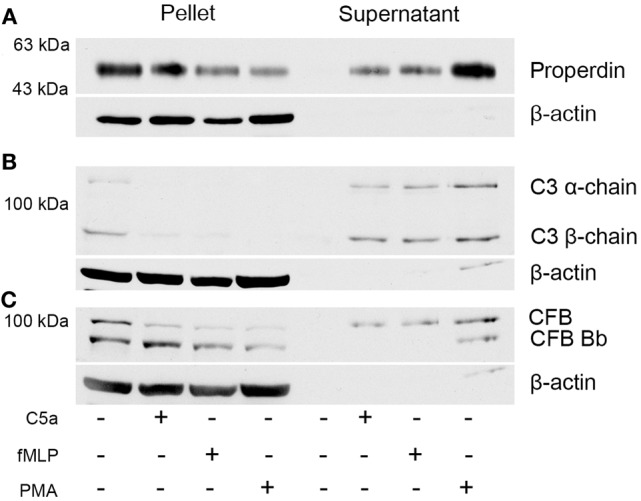
Neutrophils secrete complement proteins upon activation with PMA, fMLP, and C5a. Neutrophils were activated with C5a (1 μM), fMLP (1 μM), and PMA (20 nM) for 30 min. Cells were harvested by centrifugation, and the supernatant was collected to investigate for secreted proteins. Western blot analysis of the pellet and the supernatant reveals that neutrophils contain (A) CFP, (B) C3, and (C) complement factor B and secrete them upon activation. β-actin served as loading control.